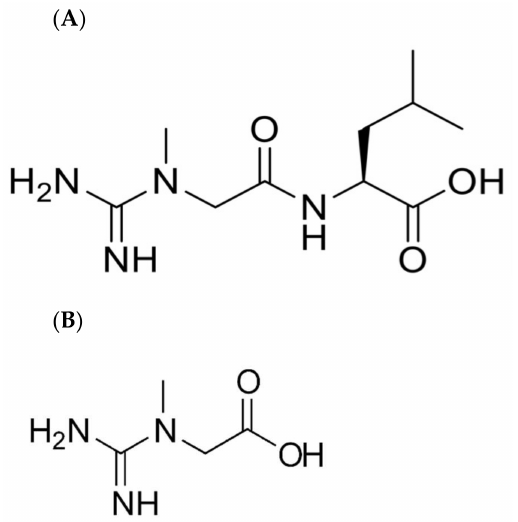
Figure 1. Chemical structures of ( A ) creatyl- L -leucine and ( B )